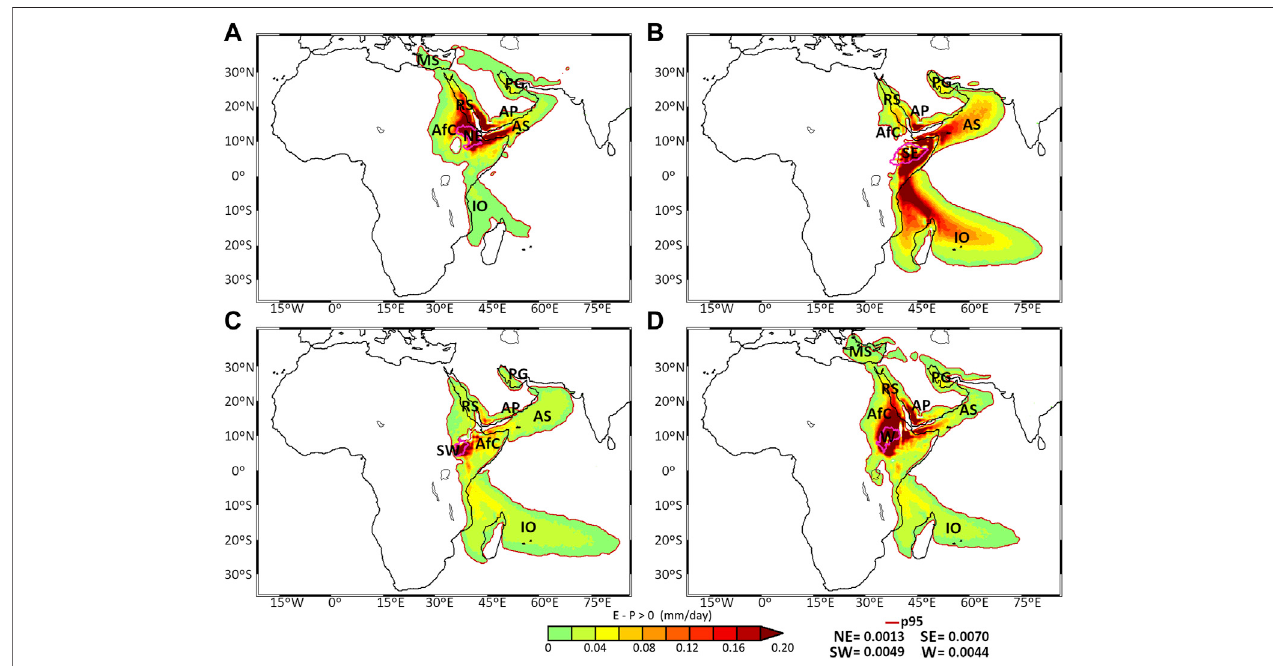
FIGURE 4 | Annual patterns of (E – P) > 0 obtained in a backward experiment for the (A) NE, (B) SE, (C) SW, and (D) W river basin groups. The extensions of the sources were delimited using percentile 95 (represented by a pink line). Period: 1980 – 2018.